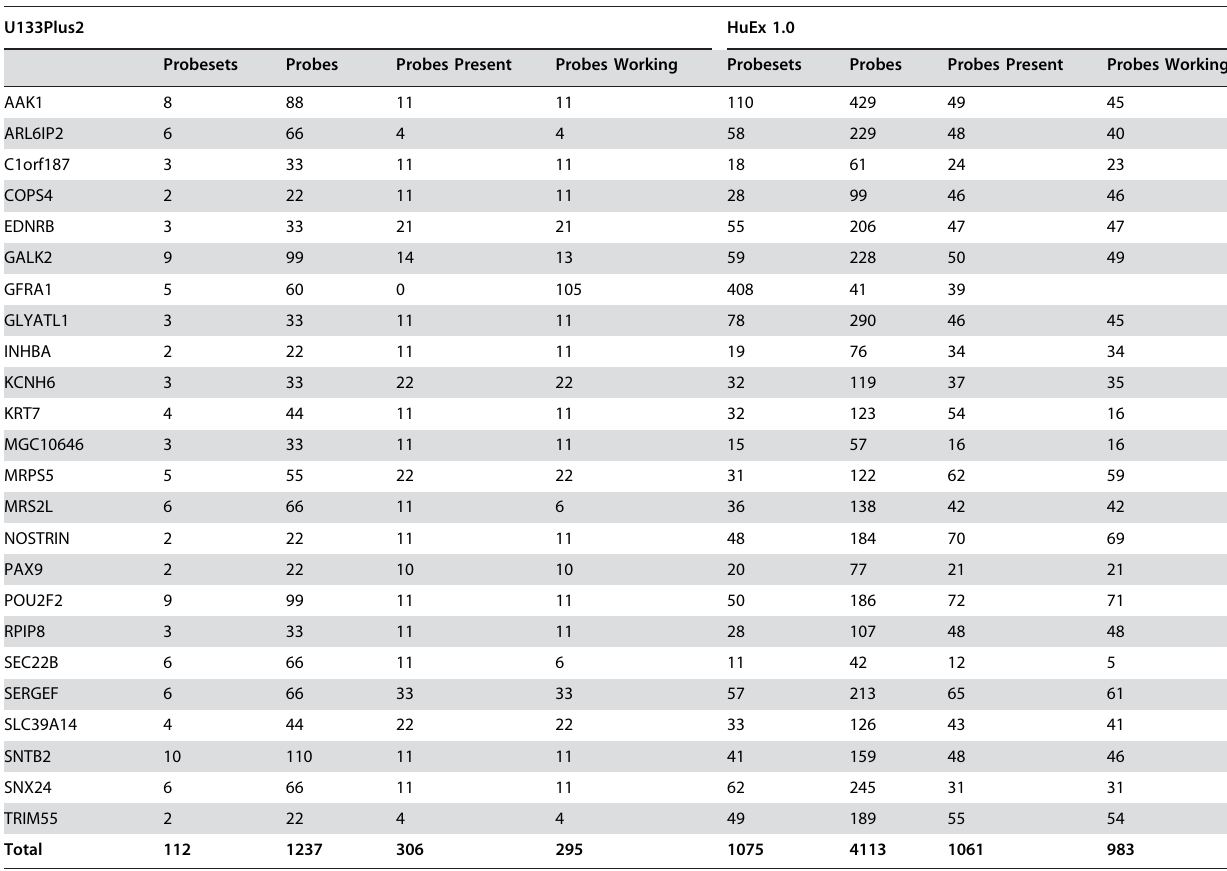
Table 1. Summary of Spike-in Clones Representation in Affymetrix Platforms .. ... .... ... ... .... ... ... .... ... ... .... ... ... .... ... ... .... ... ... .... ... ... .... ... ... .... ... ... .... ... ... .... ... ... .... ... ... .... ... ... .... ... ... . U133Plus2 HuEx